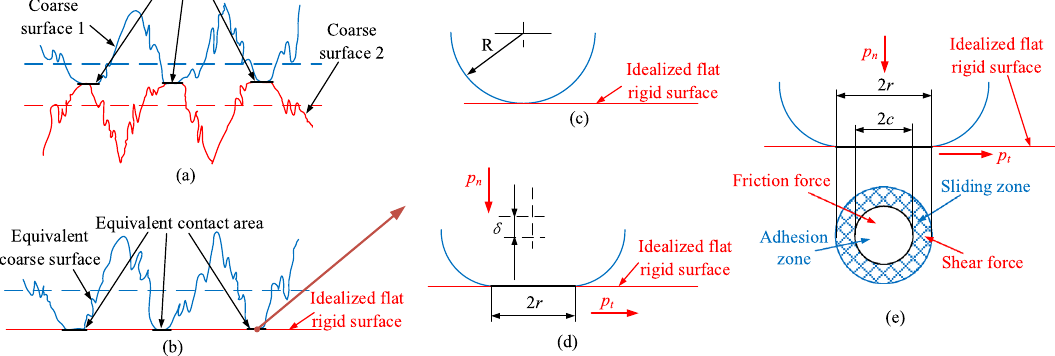
Figure 3. Schematic diagram of the contact between the slide shoes and the middle groove: ( a ) actual contact interface, ( b ) equivalent contact interface, ( c ) contact before a load is applied, ( d ) contact when a load is applied, ( e ) contact between an asperity and the idealized surface with friction